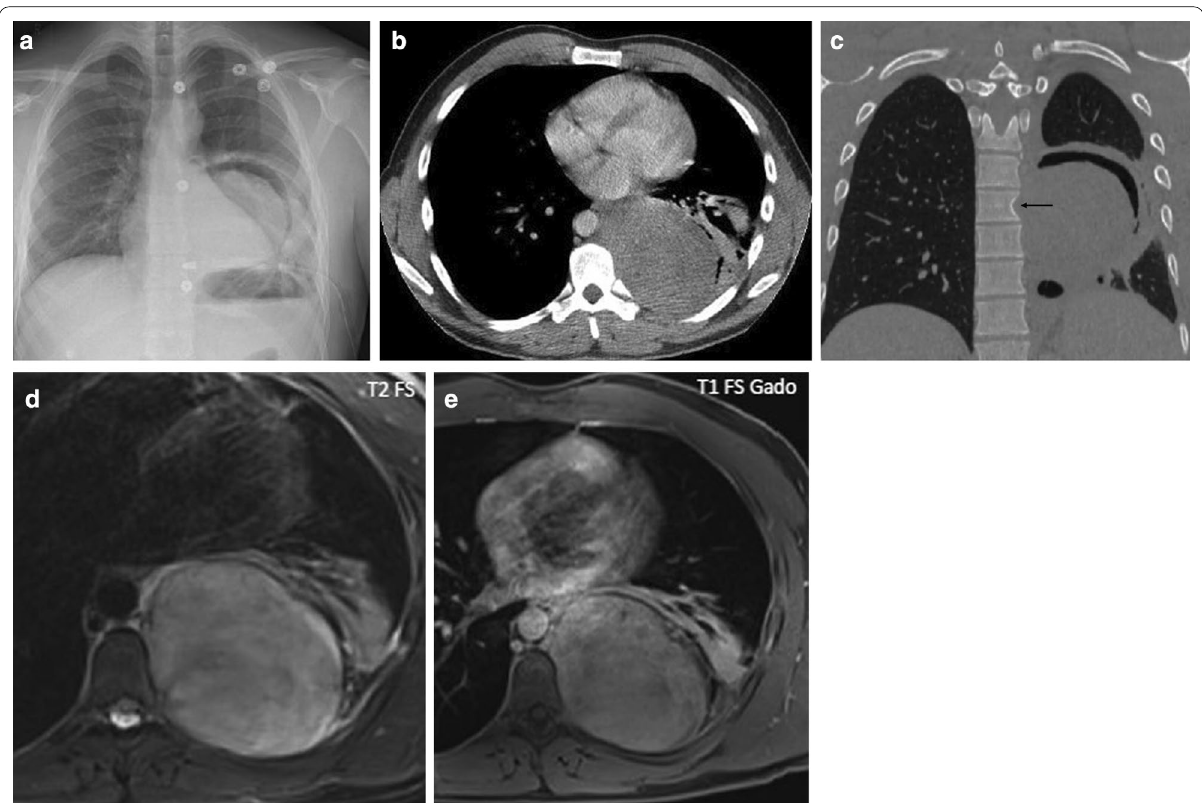
Fig. 16 Diagnosis: benign schwannoma with low mitotic activity. Technique: standard chest radiography, contrast-enhanced chest CT and MRI. Description: A 55-year-old man with respiratory distress was transferred to our hospital after drainage of a hemothorax. The antero-posterior chest radiograph ( a ) shows a large mass in the left lung with a perilesional rim of air (due to pneumothorax). On contrast-enhanced CT ( b ) the homogeneous hypointense mass is located paravertebral in the left lower lobe with vertebral scalloping (arrow on c ). There are no intralesional calcifications or necrosis. Note also the adjacent consolidation due to atelectasis. On the axial T2 FS WI MR image ( d ), the lesion has a high signal intensity and is relatively enhancing after contrast administration ( e ). Based on imaging findings and the size of the lesion, a malignant nerve sheath tumor was suggested. Histopathologic examination of the resected mass, however, did not reveal signs of malignancy but showed an 11-cm large benign schwannoma with low mitotic activity. Genetic counseling for NF-1 was